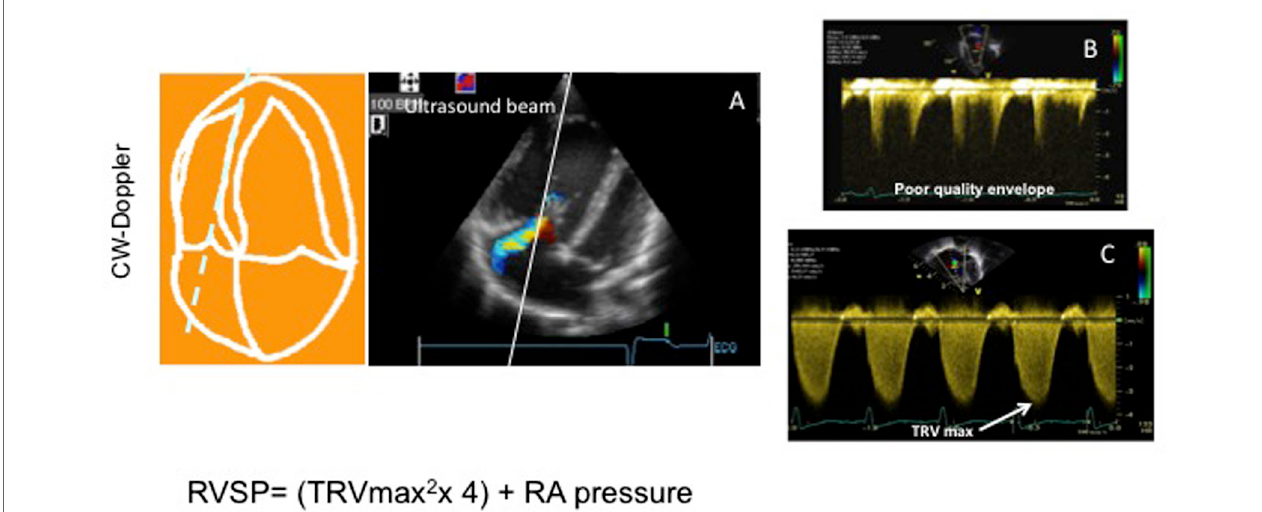
FigURe 1 | Tricuspid regurgitant velocity in a patient with pulmonary hypertension. (A) Four-chamber view showing a tricuspid jet the aligned ultrasound beam for assessment of tricuspid velocity. (b) Image showing a poor quality envelop of the tricuspid jet that does not allow accurate measurement. (C) Good tricuspid envelope allowing measurement of the maximal tricuspid regurgitant jet velocity (TRV max